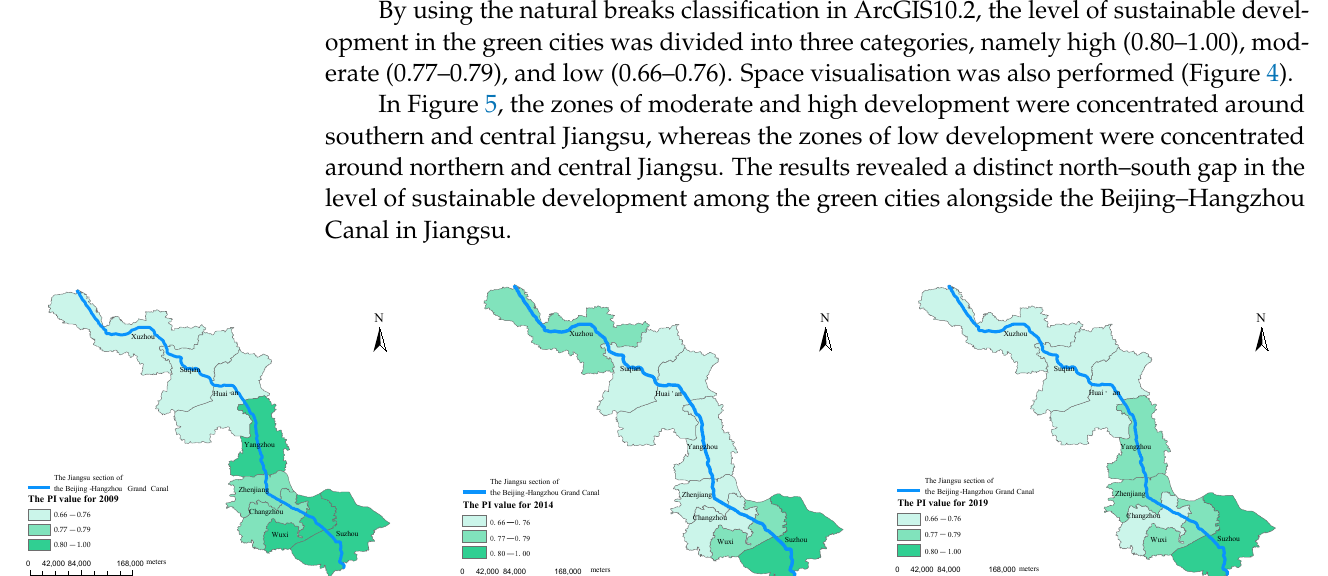
Figure 4. Comparative diagram for 2009–2019.